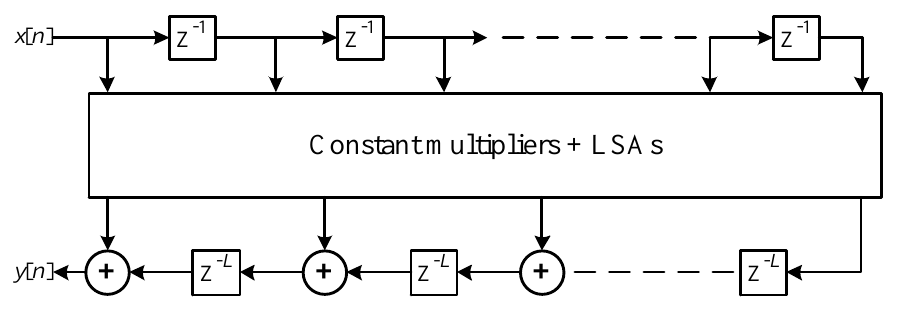
Figure 3. Filter structure for L >